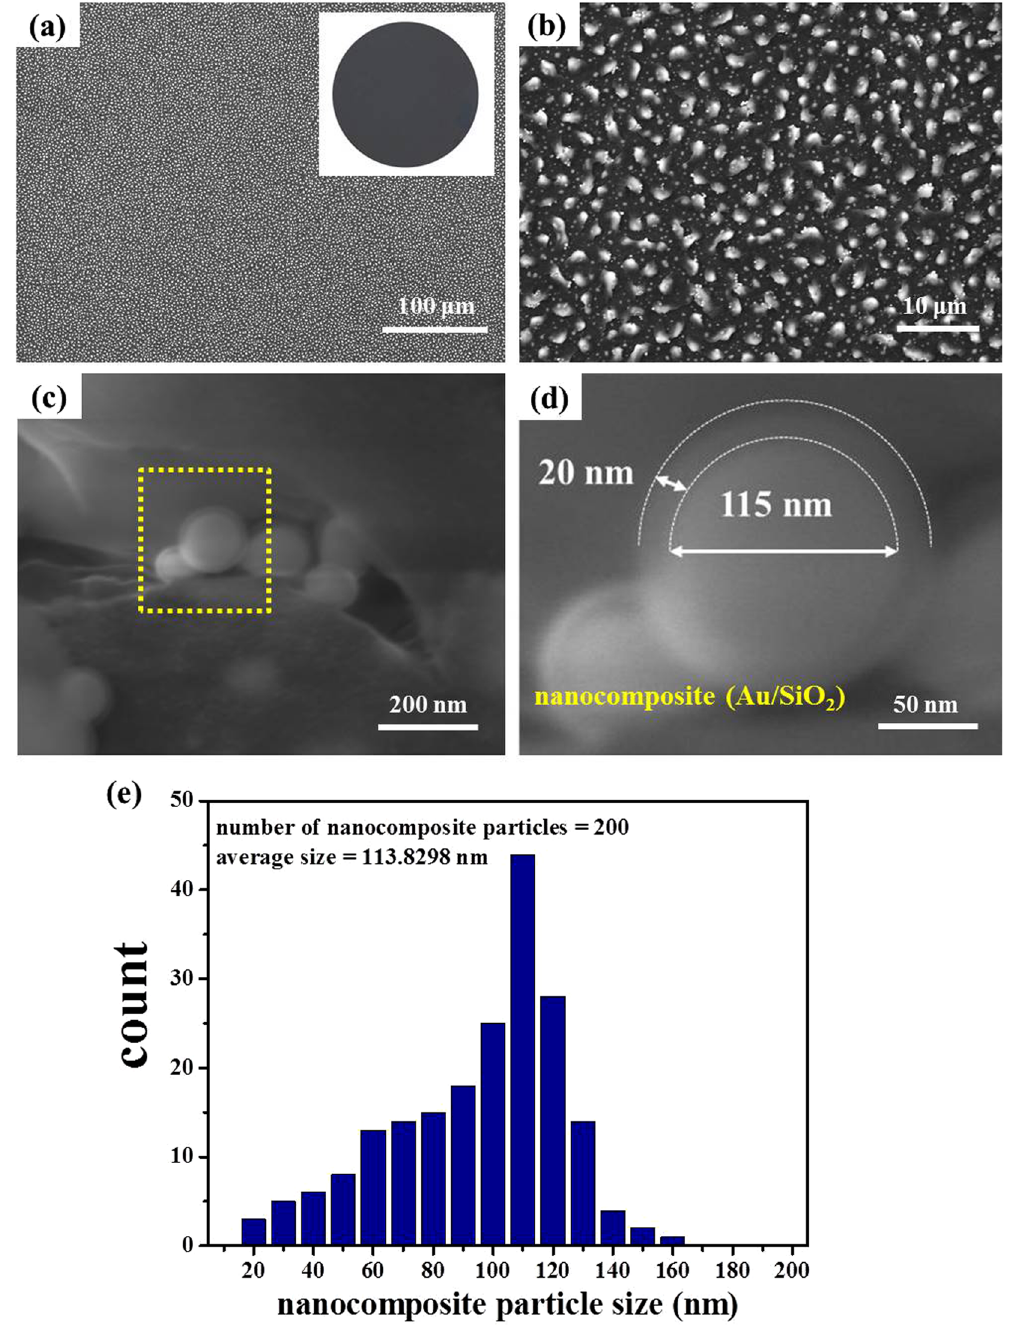
Figure 2. FESEM images of PMA. ( a ) FESEM image of pod-like nanostructures with an Au thin-film in 20 nm thickness at annealing temperature of 600 °C conditions, the insert image of (a) is the corresponding photography of full 4-inch PMA wafer. ( b ) FESEM zoom-in image of (a). ( c ) FESEM image of unit cell of pod- like nanostructures. ( d ) FESEM zoom-in image of yellow dash-square area in (c). The diameter of Au-NP is 115 nm and the thickness of SiO 2 cladding layer is 20 nm. ( e ) The typical size distribution of nanocomposite particles embedded in the pod-like nanostructures. The average nanocomposite particle size is 114